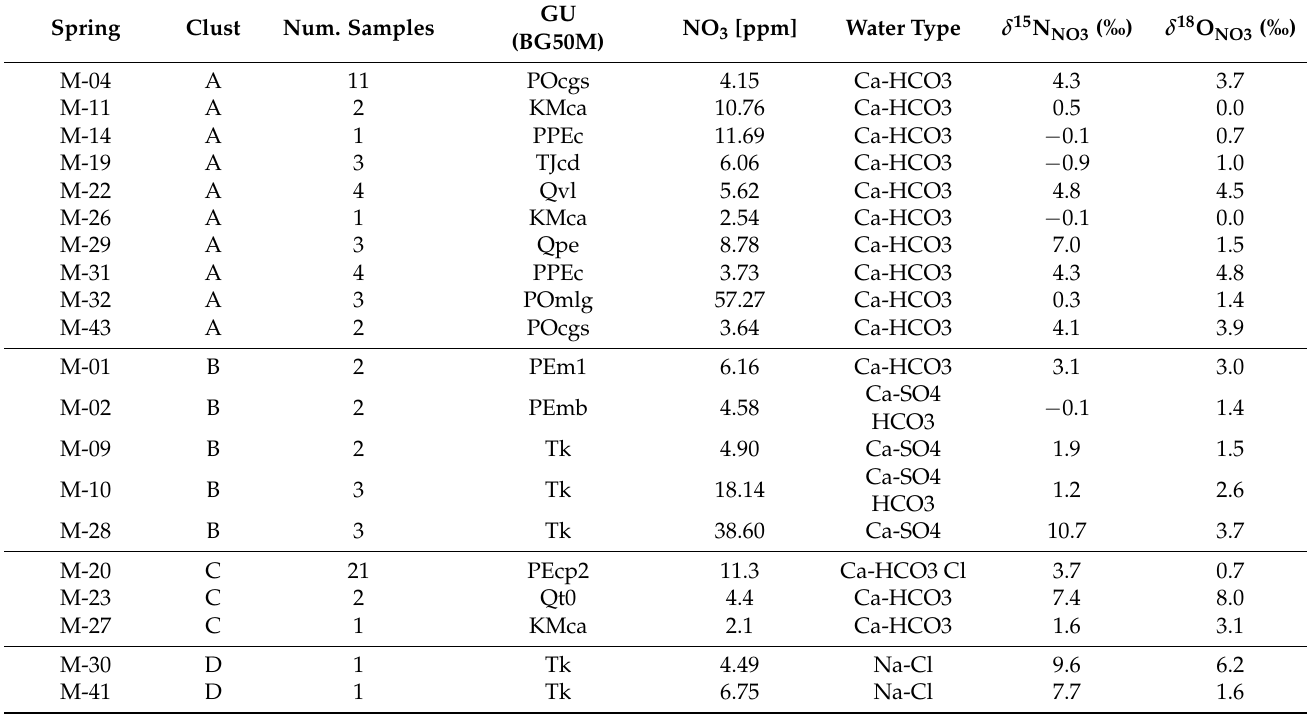
Table A8. Average values for δ 15 N NO3 and δ 18 O NO3 , of samples available of all springs and the corresponding average NO 3